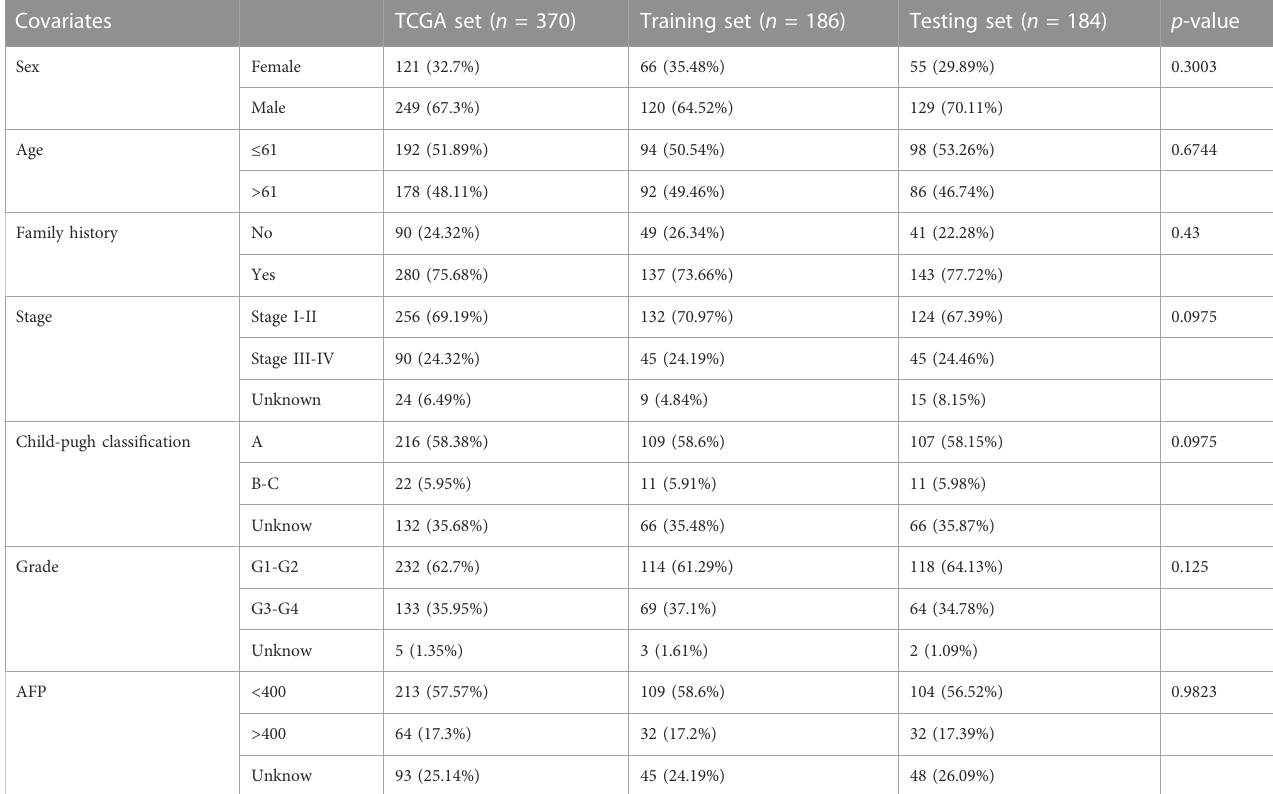
TABLE 1 Clinical features of the training cohort, testing cohort and whole TCGA-LIHC cohort.